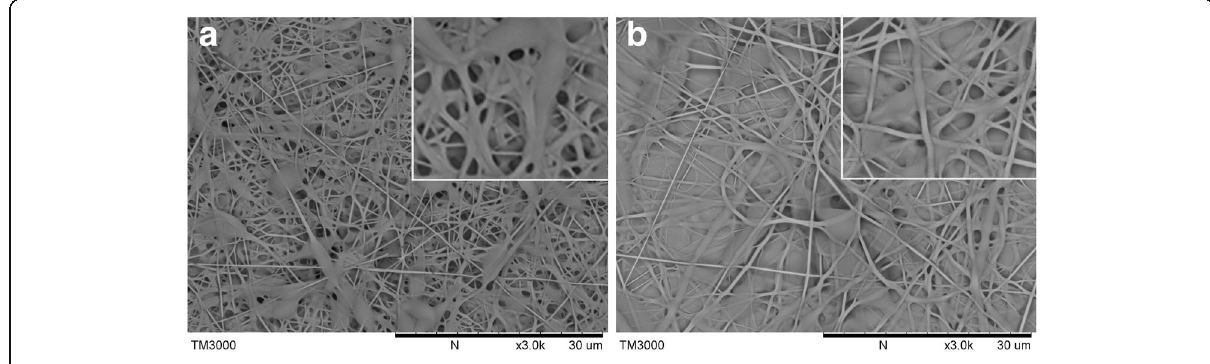
Fig. 3 SEM images of the single electrospinning experiments from a 18 wt% TPU1 in DMAc/THF of 3/1 volume ratio b 18 wt% TPU2 in DMAc/ acetone of 3/1 volume ratio. The applied voltage is 15 kV, the working distance is 10 cm, and the flow rate is 0.15 ml/h